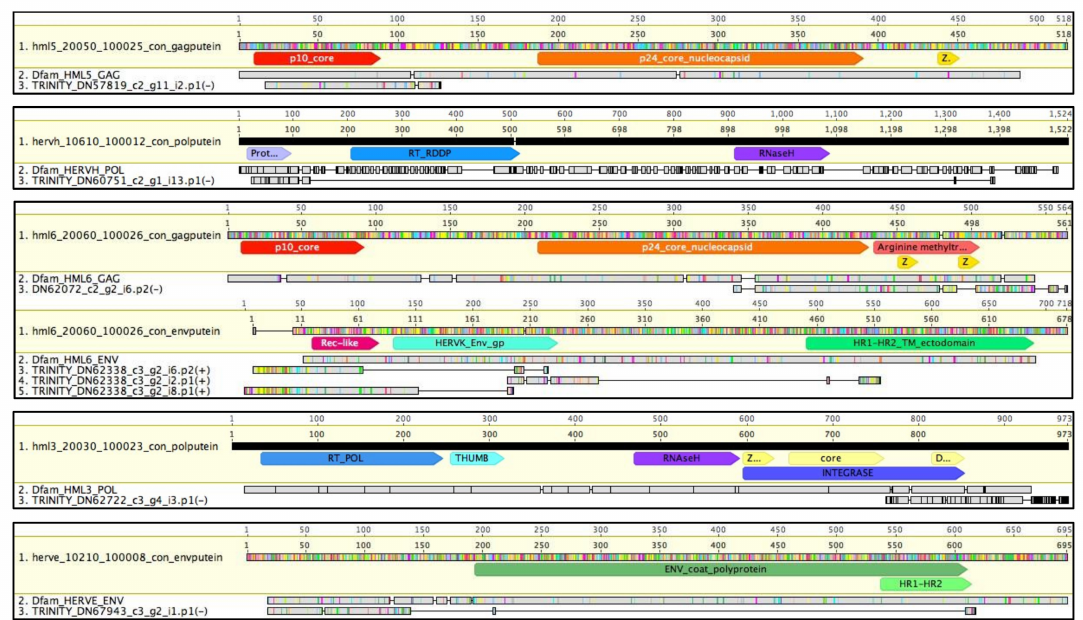
Figure 5. HERV puteins alignment with the respective consensus sequences from Dfam and Vargiu et al. [9]. In the latter, conserved domains have been annotated: dark yellow Z = Zinc finger motif, gp = glycoprotein, HR1-HR2_TM = transmembrane heptad repeats 1 and 2, RT = reverse transcriptase, light yellow z and D = zinc- and DNA-binding domains, respectively. Colored residues indicate divergent amino acids as compared to the reference, which is highlighted by the yellow